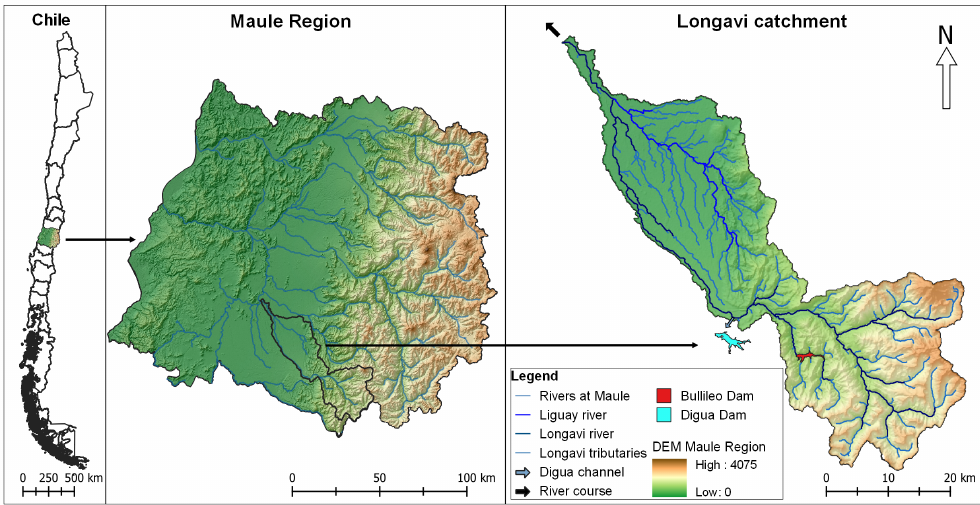
Figure 1. Localization of Longaví